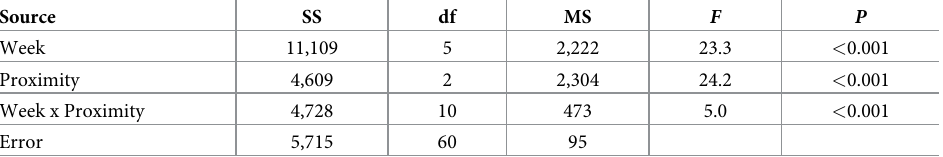
SS represents sum of squares and MS represents mean